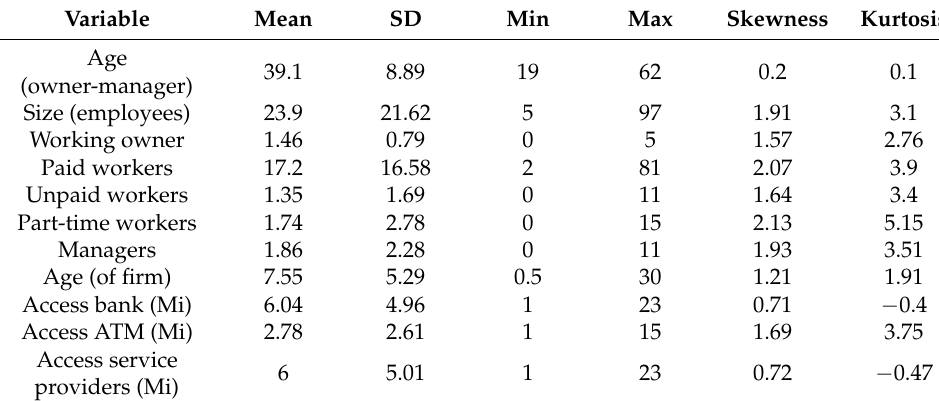
Table 2. Sample profile for continuous variable